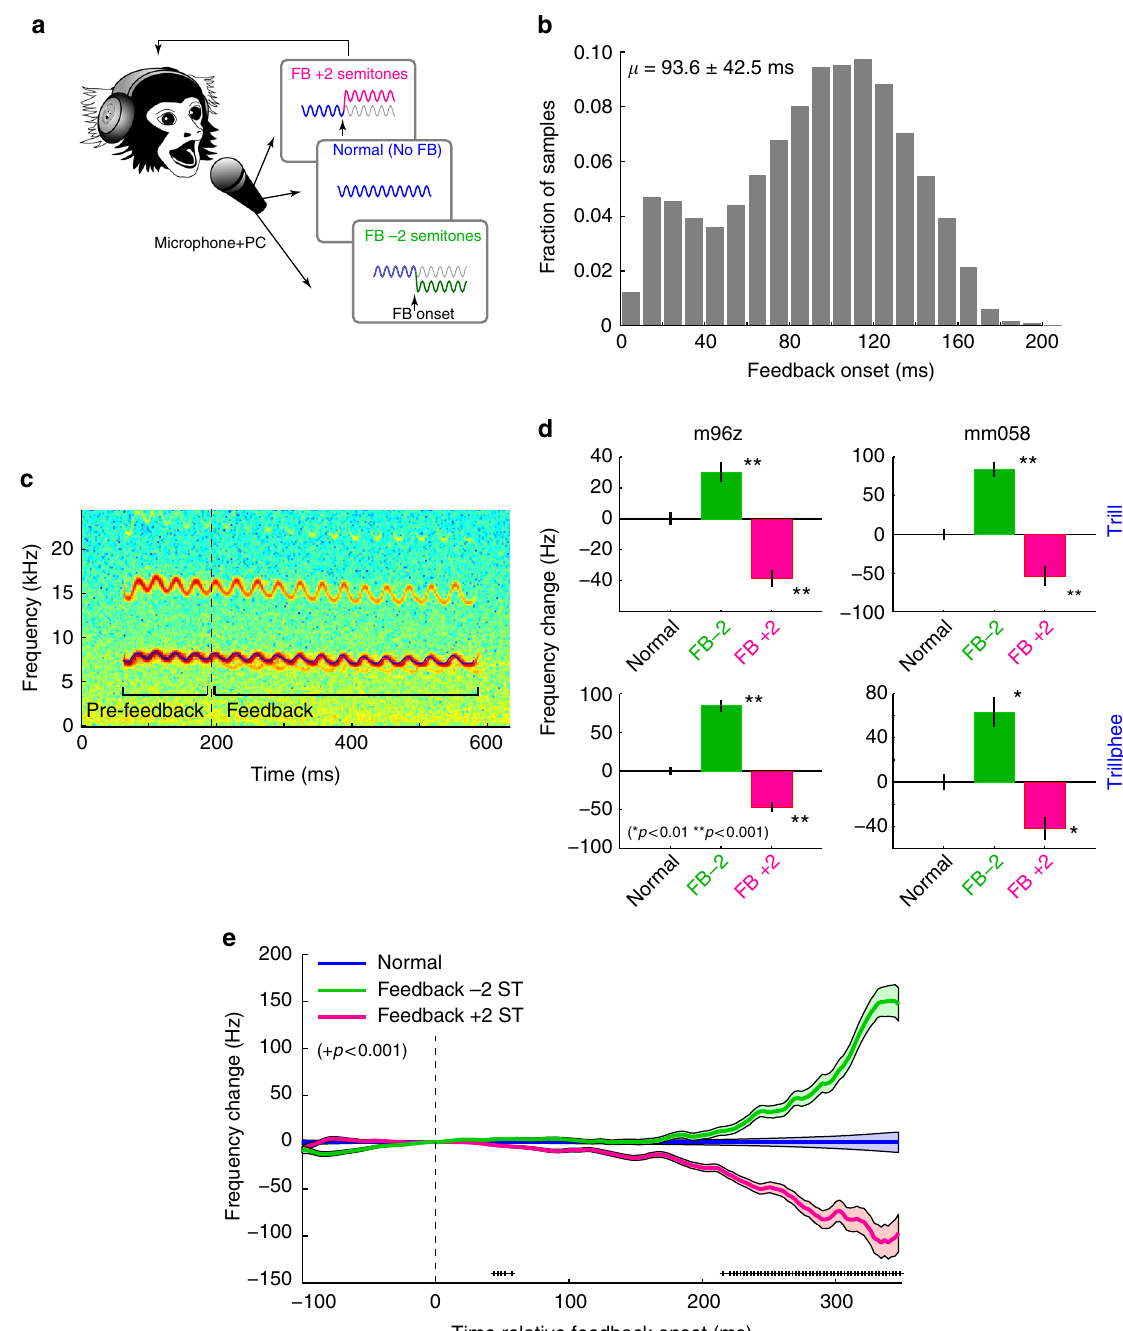
Fig. 1 Feedback-dependent control of vocal frequency in marmosets. a Schematic illustration of shifted feedback experiment including + 2 and − 2 semitone feedback (FB) frequency shifts. b Distribution of feedback trigger times. c Sample trill vocalization illustrating − 2ST (semitone) feedback including pre- feedback and feedback time ranges. The shifted feedback is weakly visible in the spectrogram. Frequency contour is highlighted (blue). d Comparison of mean vocal frequency change between pre-feedback and feedback time periods for normal, − 2ST, and + 2ST conditions demonstrating compensatory vocal changes in the opposite direction of the feedback shift. Results are shown separately for trill (top) and trillphee (bottom) vocalizations, and for the two animals. Error bars: standard error (SEM); * p < 0.01, ** p < 0.001 for each feedback vs. normal (Kruskal – Wallis test). e Time course of compensatory vocal changes in trills during shifted feedback demonstrating expected vocal compensation with a 215 ms latency from feedback onset (Error bars: SEM, + p < 0.001, Kruskal – Wallis). Sample sizes and statistical details may be found in the Supplementary Note